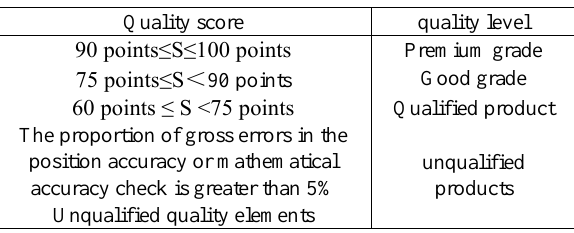
Table 8 . Unit achievement quality assessment grade.